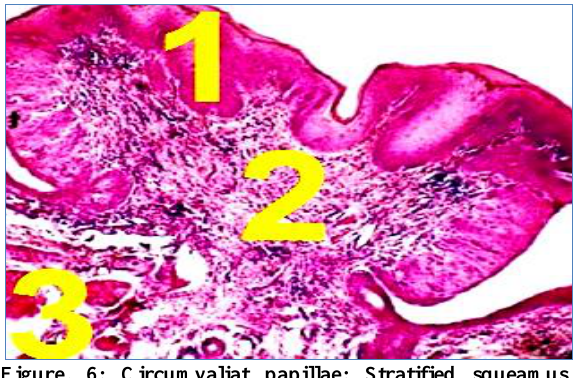
Figure, 6: Circumvaliat papillae: Stratified squeamus epithelial tissue (1) lamina propria (2) skeletal muscles (3) (H and E) stain 400X.